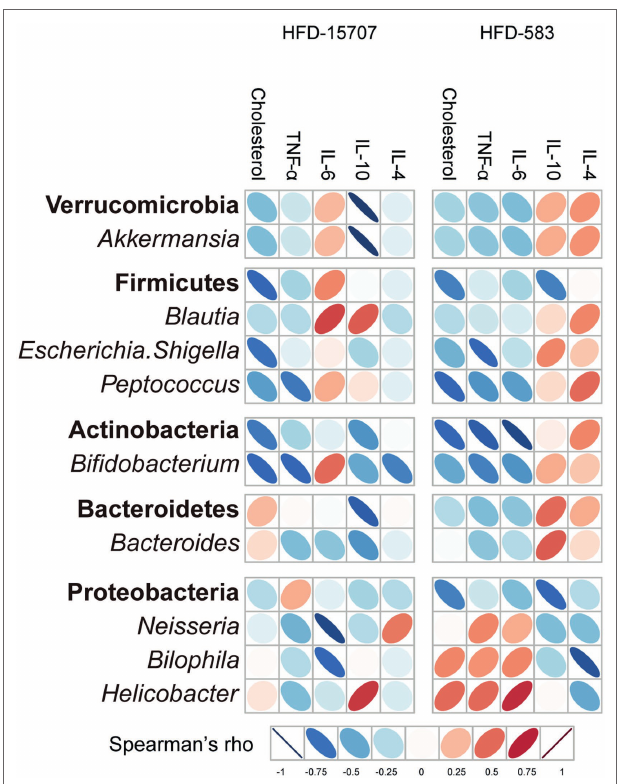
FIGURE 7 | Spearman’s correlation analysis between selected phyla/genera and cholesterol/immune response results of ATCC 15707 and BCBL-583 in HFD mouse models after 9 weeks. Cholesterol and inflammatory cytokines are correlated with selected phyla and genera